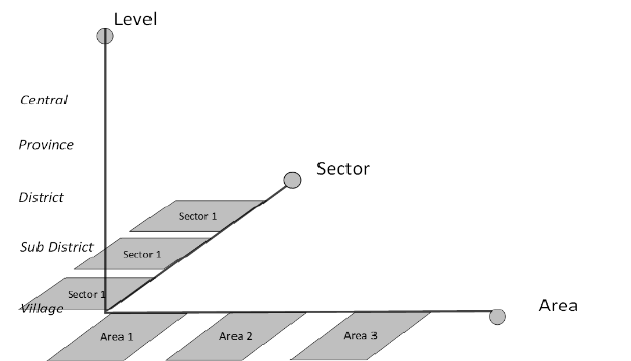
Fig. 1. PAD and geographical areas in a three-dimensional